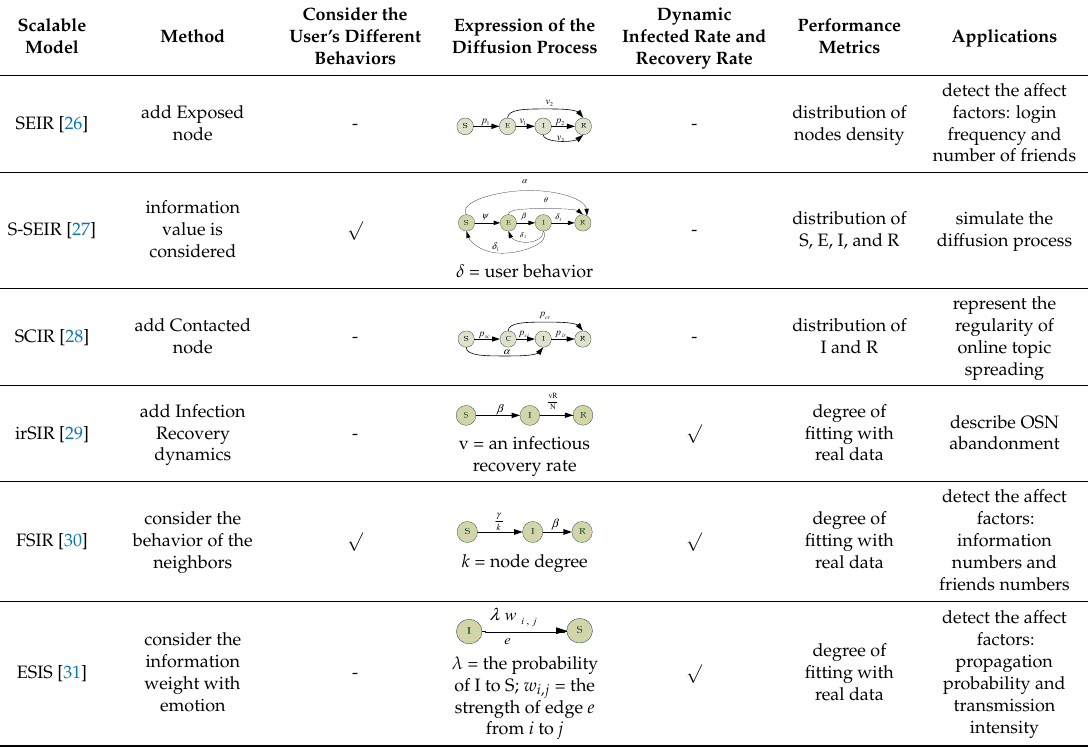
Table 1. Comparison of Epidemic Models in the Literature.